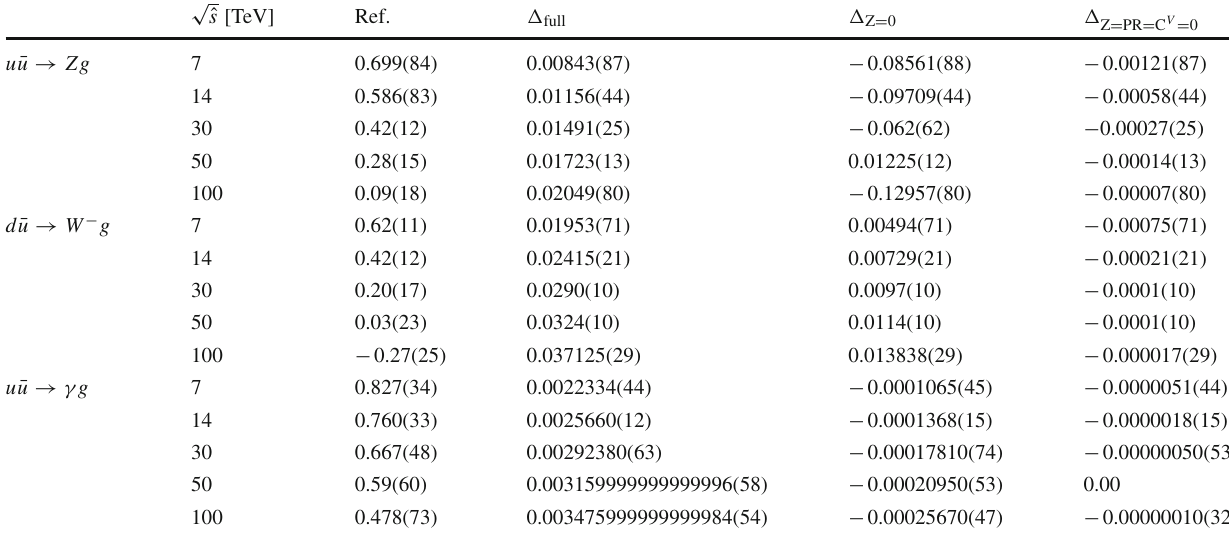
Table 4 Comparison of our K factor results with reference K factor results (“ref.”) from [11] ( u ¯ u → Zg ), [14] ( d ¯ u → W − g ) and